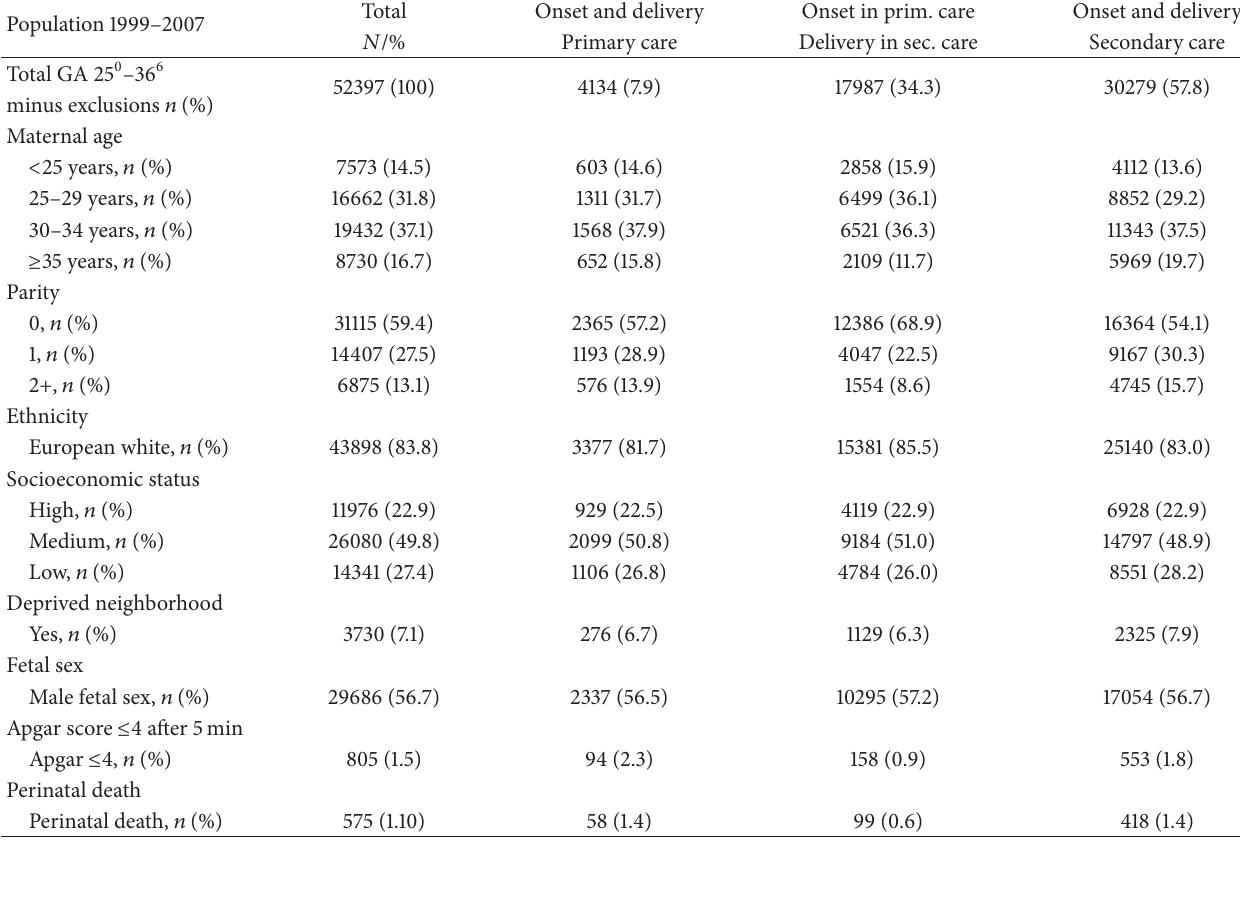
Table 2: Baseline characteristics and outcome of 52,397 women with preterm delivery (GA 25 +0 –36 +6 ).